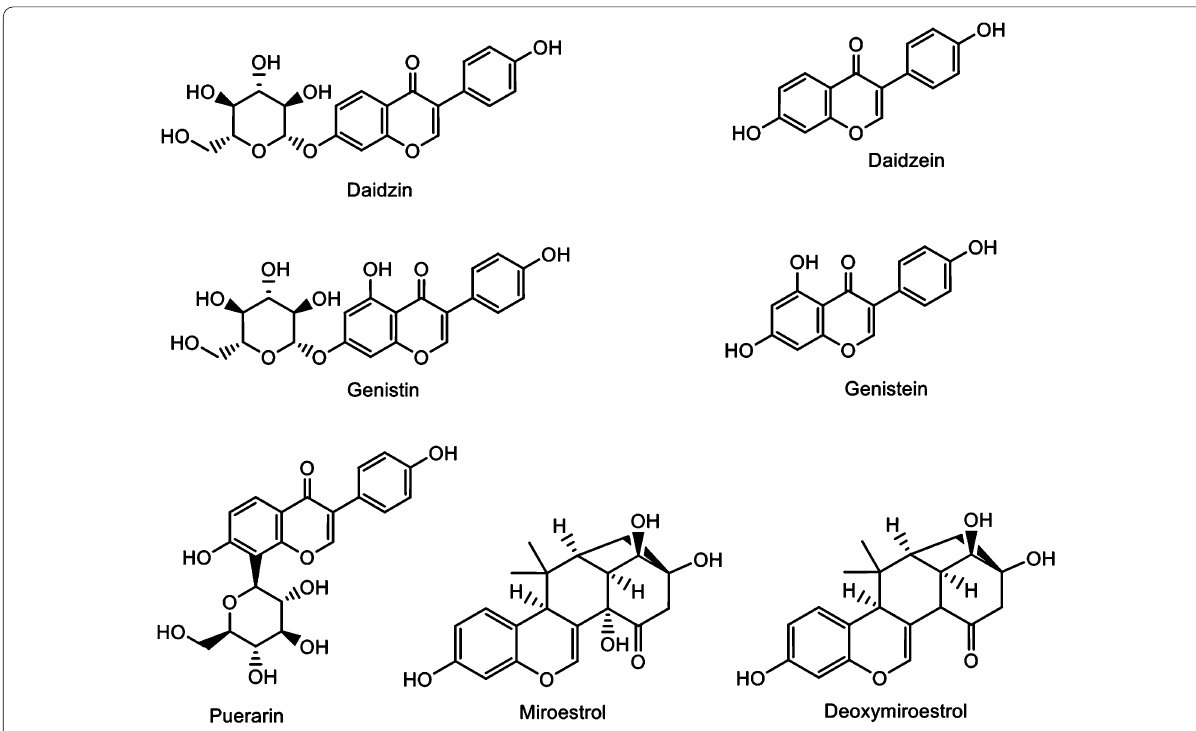
Fig. 1 Chemical structures of phytoestrogens, including PUE, DZ, GT, DZe, GTe, MI, and